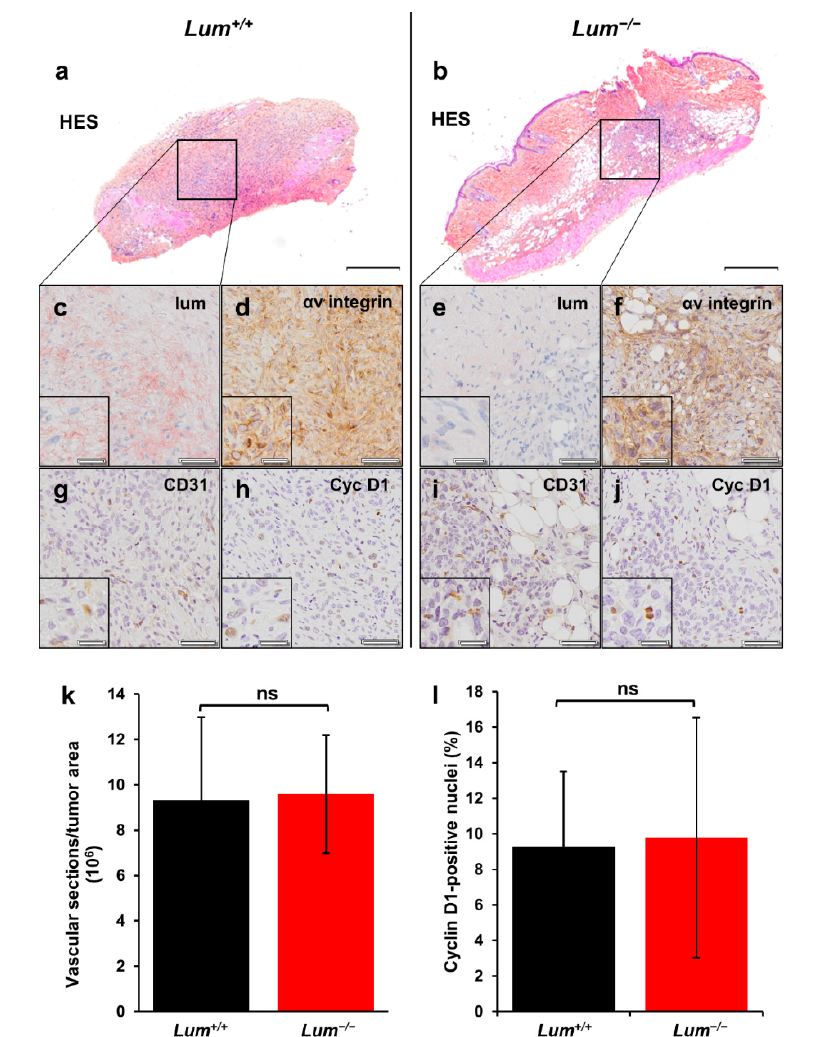
Figure 3. Histological and immunohistochemical analysis of ovarian tumor sections. ( a , b ) Example of s.c. allograft whole sections stained with HES (top panel, scale bar 500 µm) in wild-type ( Lum +/+ ) ( a ) and lumican-deficient ( Lum − / − ) mice ( b ); ( c – j ) IHC analyses of ovarian allografts in tumors implanted in Lum +/+ ( c , d , g , h ) and Lum − / − ( e , f , i , j ) mice; ( c , e ) Microscopic views of s.c. allograft whole sections IHC allowing visualization of lumican within tumors implanted in Lum +/+ mice ( c ) while it is not detected in tumors from Lum − / − animals ( e ) (scale bar 50 µm). Insets show higher magnification (scale bar 20 µm) of stromal margin surrounding ovarian tumor allografts. Ovarian tumors from Lum − / − animals lack immunoreactive material confirming the absence of any lumican gene product; ( d , f ) IHC allowing visualization of α v integrin (scale bar 50 µm). Insets show higher magnification (scale bar 20 µm) of endothelial cells ovarian tumor allografts in tumors implanted in Lum +/+ mice ( d ) and in tumors from Lum − / − animals ( f ); ( g , i ) CD31 immunostaining in tumors implanted in Lum +/+ mice ( g ) and in tumors from Lum − / − animals ( i ) (scale bar 50 µm). Insets show higher magnification (scale bar 20 µm); ( h , j ) Cyclin D1 immunostaining in tumors implanted in Lum +/+ mice ( h ) and in tumors from Lum − / − animals ( j ) (scale bar 50 µm). Insets show higher magnification (scale bar 20 µm); ( k , l ) Quantification of percentage of CD31-positive blood vessels ( k ) as well as relative cyclin D1-positive areas (number of positive cyclin D1 tumor cell nuclei normalized to the total number of tumor cell nuclei) ( l ) (mean ± SD, ns: not significant). The quantification of the MicroVascular Density (MVD) was based on a manual counting of full vascular sections formed by CD31-positive endothelial cells. All acquisitions were performed with a 20× magnification.